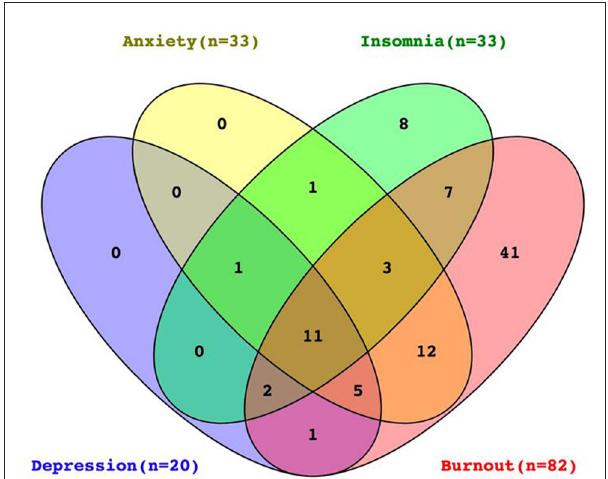
FIGURE1 Venn diagram illustrates the degree of overlap between burnout status and clinically significant scores for depression, anxiety, and insomnia for participants with complete data on all four measures ( N = 173). Ellipses of four colors, respectively, represent different adverse mental statuses. Yellow represents anxiety ( n = 33), purple is depression ( n = 20), green is insomnia ( n = 33), and red is burnout ( n = 82). The public collection part of ellipses means participants had two or more mental problems at the same time, and the figure in the ellipse represents the number of participants with this kind of psychological